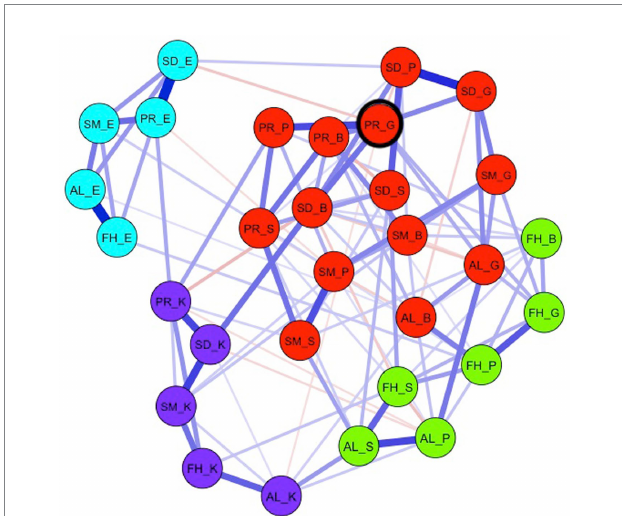
FIGURE 3 The network model of interest in personalized medicine. FH, future health; AL, adapt lifestyle to stay healthy; SM, having a say in medical decisions; SD, share medical data to improve healthcare; PR, participate in scientific research to improve healthcare; K, knowledge; B, behavior; E, emotion; S, self-efficacy; P, personal value; G, general value. The colors of the nodes correspond to detected communities within the network. Blue (red) edges represent positive (negative) relations between nodes. The most central node (PR_G) is highlighted with a black